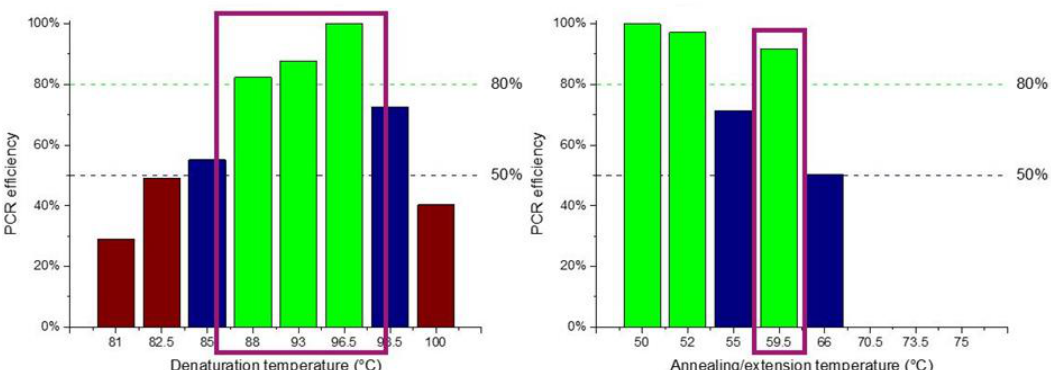
Figure 3. PCR temperatures for optimal amplification efficiency following a two-temperature (2T) protocol. The bars represent band intensities on the gel normalized with the most intensive one (100%). Green, blue, and brown bars indicate temperature ranges achieving amplification efficiency higher than 80%, between 50 and 80%, and lower than 50%, respectively.